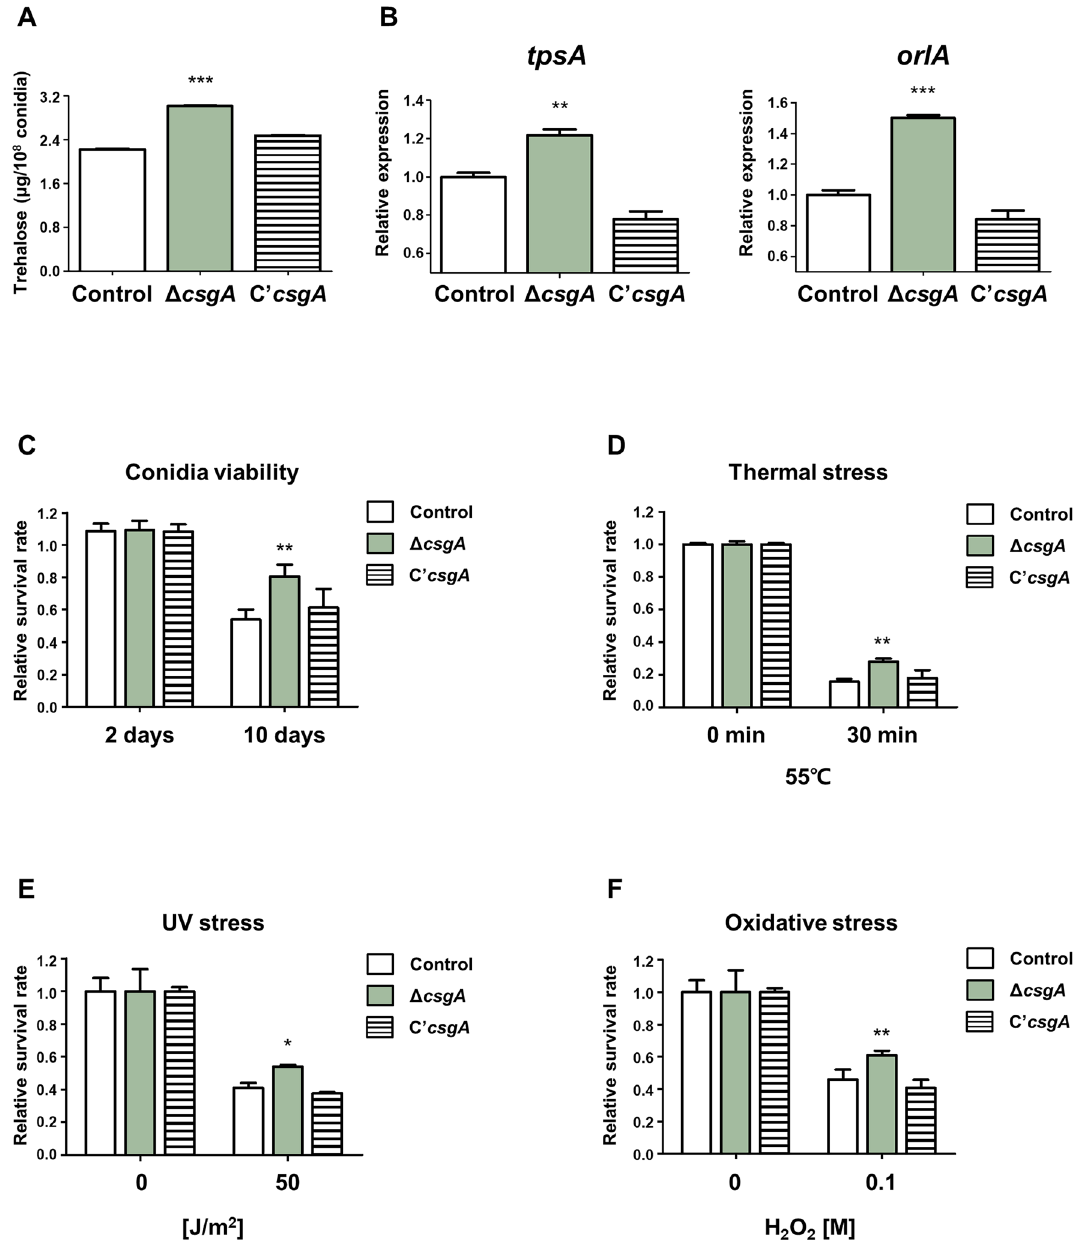
Figure 5. Characterization of csgA function in conidia. ( A ) Trehalose levels in conidia from control (TNJ36), Δ csgA (THJ13.1), and C’ csgA (THJ28.1) strains. ( B ) mRNA expression levels of tpsA and orlA in conidia from each strain. ( C ) Viability of conidia from each strain grown for 2 and 10 days. ( D ) Thermal stress response of each strain following exposure to 55 °C temperature. ( E ) UV stress response of each strain following exposure to UV light. ( F ) Oxidative stress response of each strain following exposure to 0.1 M H 2 O 2 . * p < 0.05, ** p < 0.01, *** p <